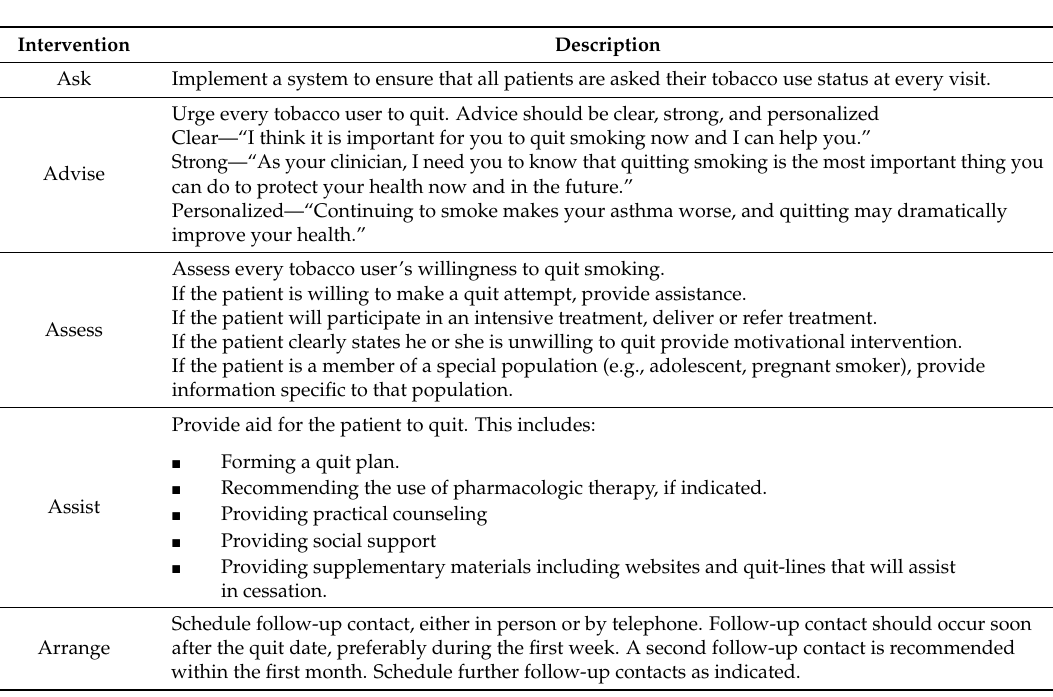
Table 3. The “5A’s” model for treating tobacco use and dependence [29].